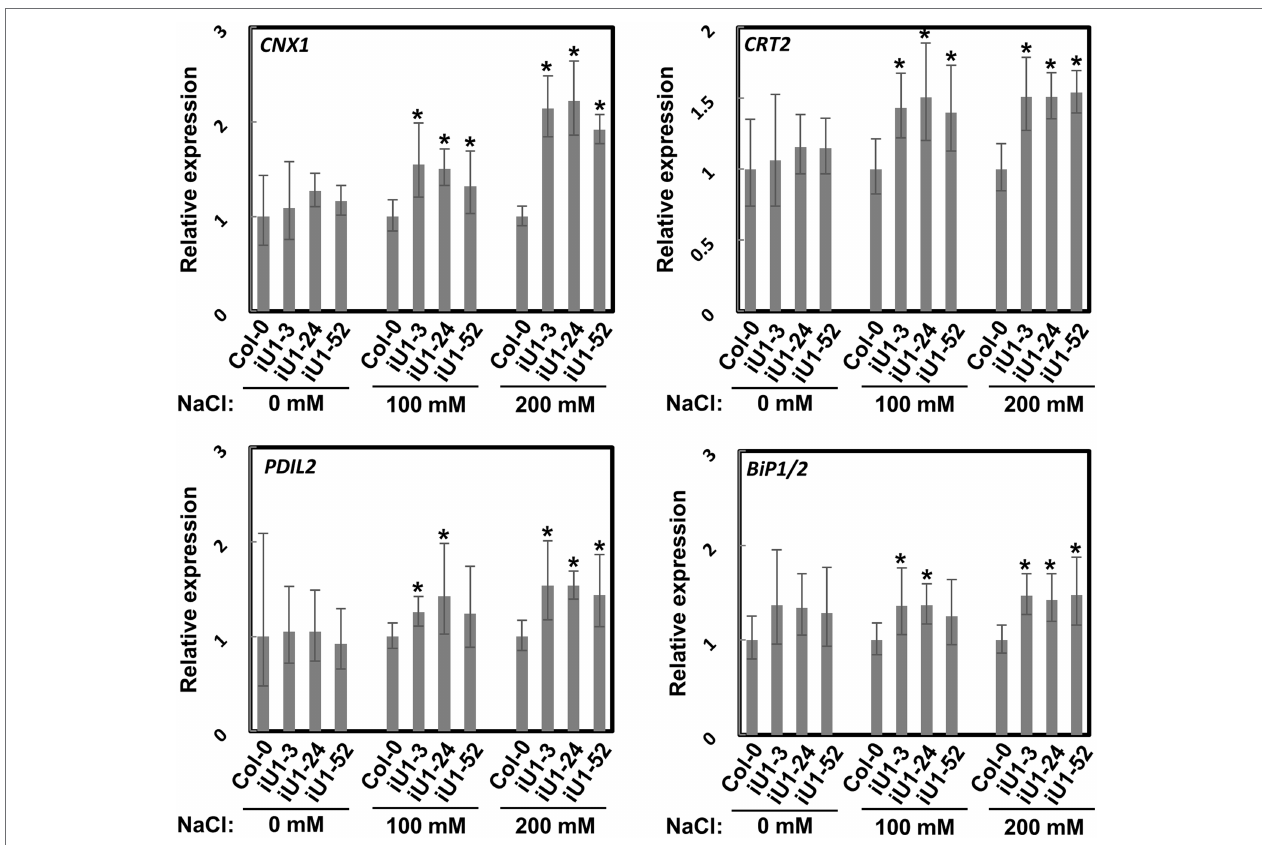
FIGURE 5 | Upregulation of ER stress marker genes in iU1s under salt stress. Seedlings grown on MS agar plates supplemented with or without salt stress for 14 days were used for total RNA extraction, followed by RT-qPCR. Data are normalized to PP2A and presented as the means ± SD of four biological replicates, each with technical triplicates. * p < 0.05, Student’s t